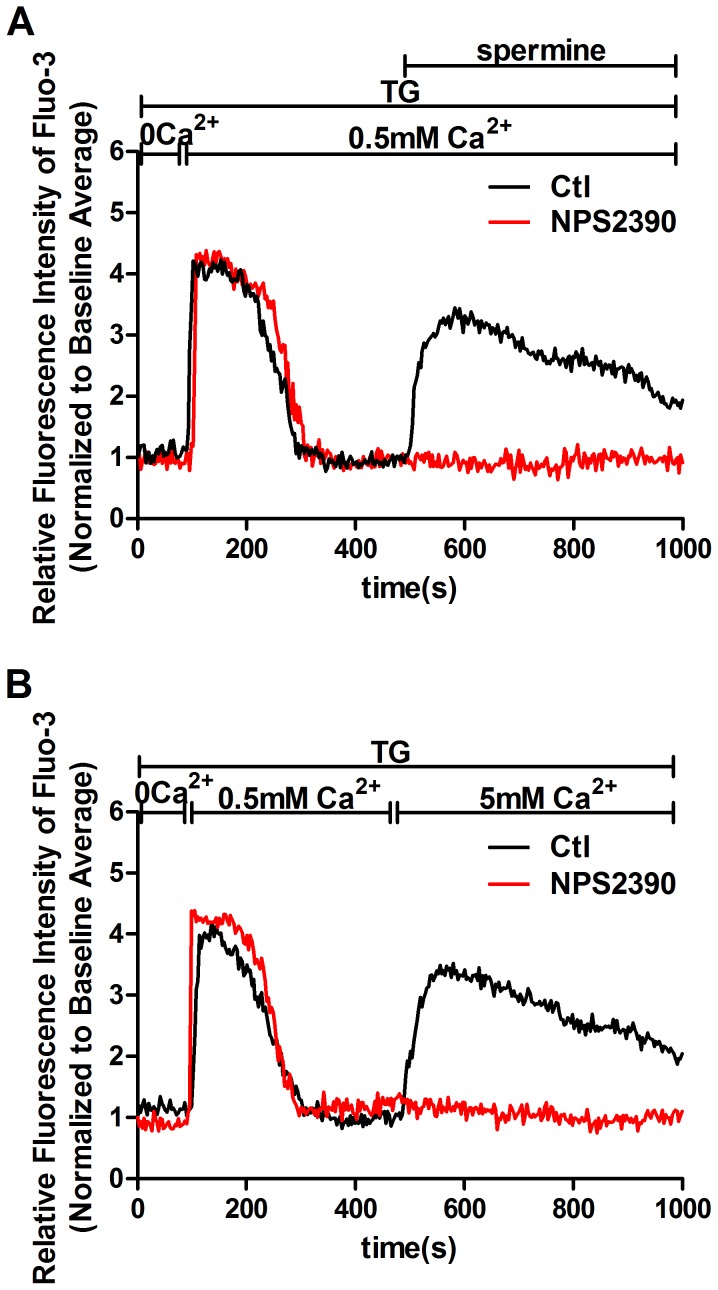
CaSR agonists mediate Ca2+ influx in store-independent manner.[Ca2+]i dynamics were monitored by Fura-3 fluorescence methods. Representative traces are shown in A–B. (A) In the presence of 1 µM TG, a change in [Ca2+]o from 0 to 0.5 mM induces a rise in [Ca2+]i, and then, addition of 3 mM spermine evokes an additional substantial increase in [Ca2+]i under conditions where Ca2+ stores are already depleted. The store-independent calcium influx induced by 3 mM spermine was blocked by pretreatment with 10 µM NPS2390 (p<0.05 vs. Ctl, n = 5). (B) A restoration of [Ca2+]o from 0 to 0.5 mM induces a rise in [Ca2+]i in the presence of 1 µM TG, and then, a change in [Ca2+]o from 0.5 to 5 mM evokes an additional substantial increase in [Ca2+]i under conditions where Ca2+ stores are already depleted. The store-independent calcium influx due to 5 mM [Ca2+]o was blocked by pretreatment with 10 µM NPS2390 (p<0.05 vs. Ctl, n = 5). The results were from at least three independent experiments, and each experiment measured 20 to 40 cells.